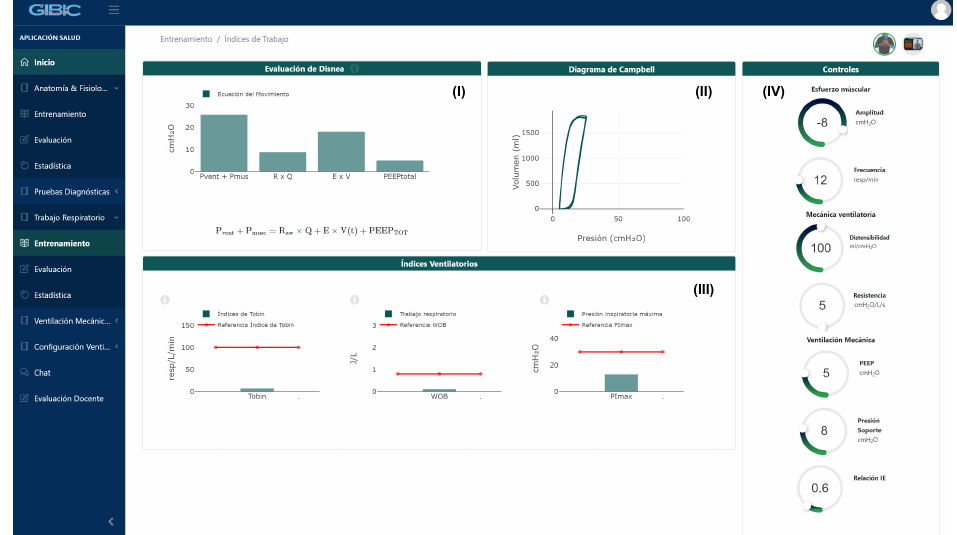
Figure 3. Graphical interface of the “Work of Breathing” module with its sections: ( I ) assessment of dyspnea, ( II ) Campbell diagram, ( III ) ventilatory indexes and, in red, the thresholds indicating high muscle effort, and ( IV ) user